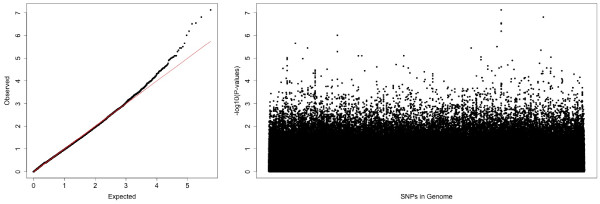
QQ- and Manhattan-plot for the phenotype waist circumference in the Bogalusa Heart Study.